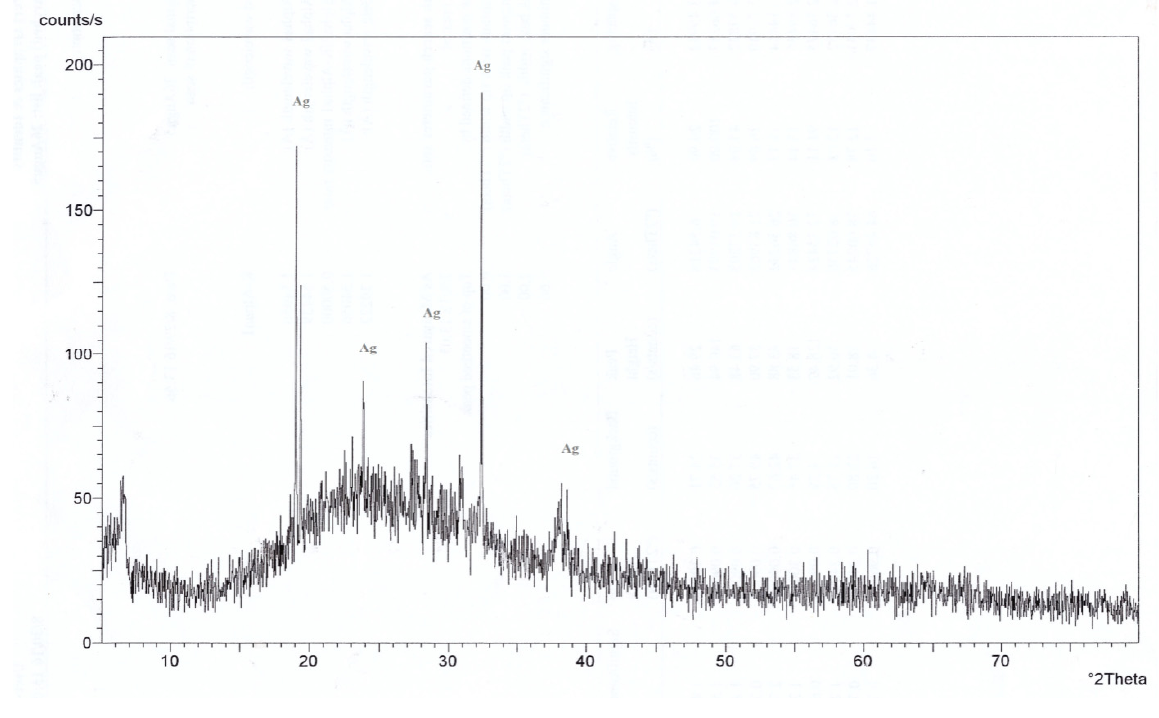
Figure 5. TEM micrograph ( A , B ) composite 500µL AgNPs–500µL ZnONPs; ( C , D ) composite 750µLAgNPs–250µL ZnO nanoparticles; ( E,F ) composite 750µL TiO 2 nanoparticles–250µL ZnO nanoparticles.